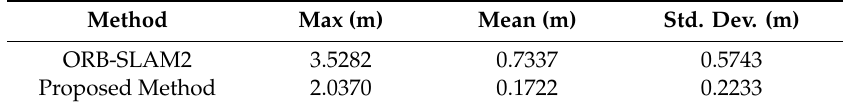
Table 4. Statistical results of matching error between the models generated by the two methods in loop closure experiment and the ground truth LiDAR data.